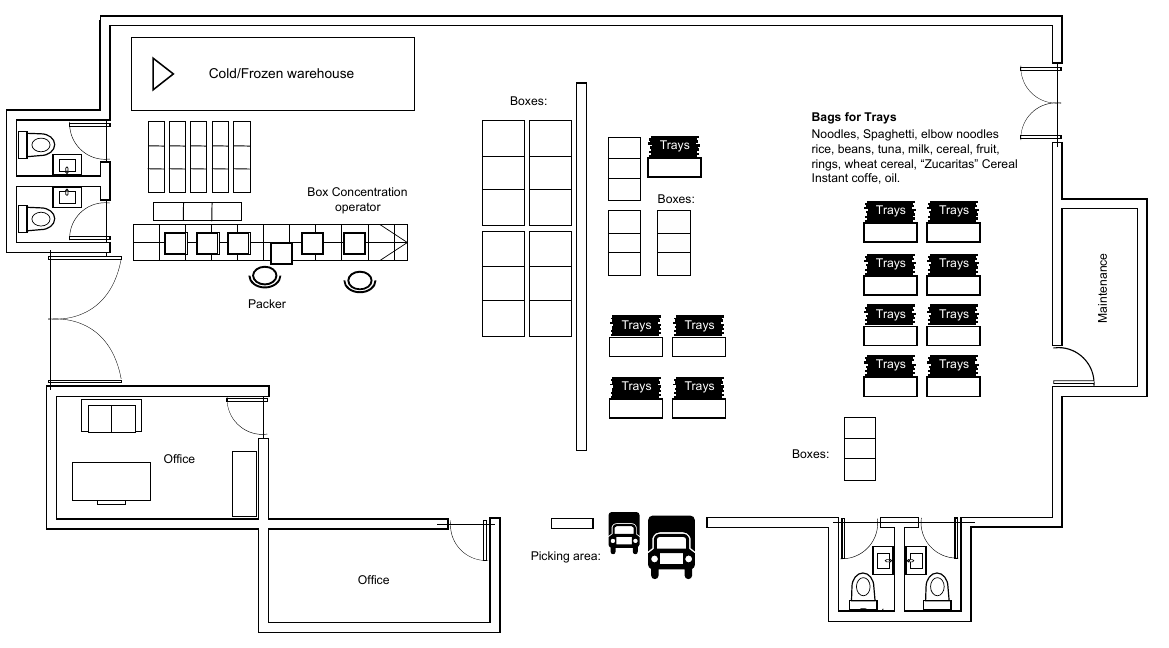
Figure 8. Optimistic scenario layout.